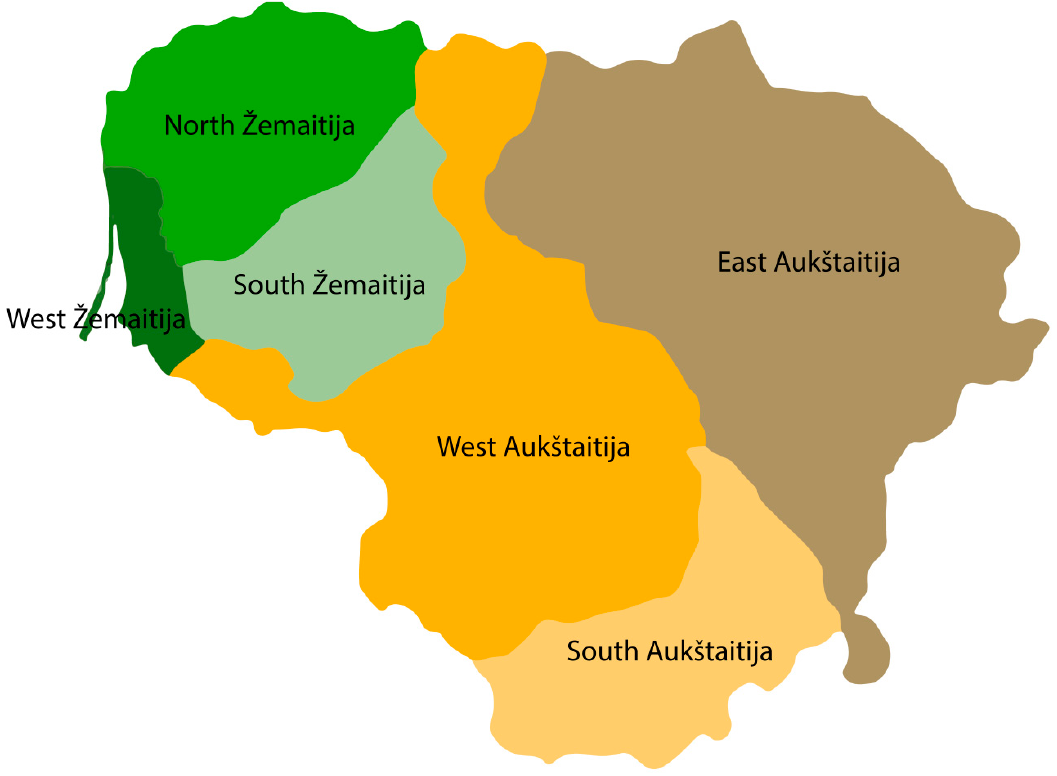
Figure 1. Map of Lithuanian ethnolinguistic regions. Six ethnolinguistic regions are distinguished in Lithuania: three regions from Aukštaitija (west, south, and east) and three regions from Žemaitija (north, west, and south). Figure reproduced from A. Urnikyte et al., 2019, under a Creative Commons Attribution 4.0 International License (http://creativecommons.org/licenses/by/4.0/).